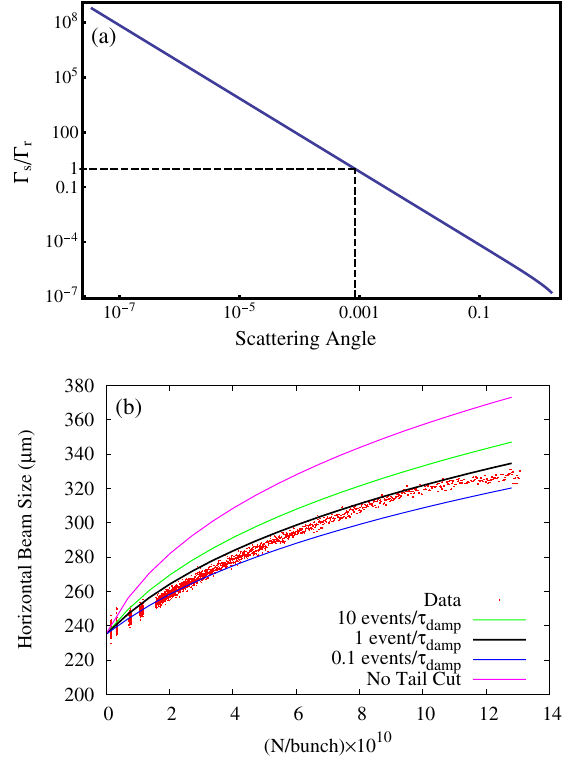
FIG. 2. (a) Events which occur less than once per damping time are excluded from the calculated growth rate. (b) Equilibrium beam size calculations assuming different cutoffs.